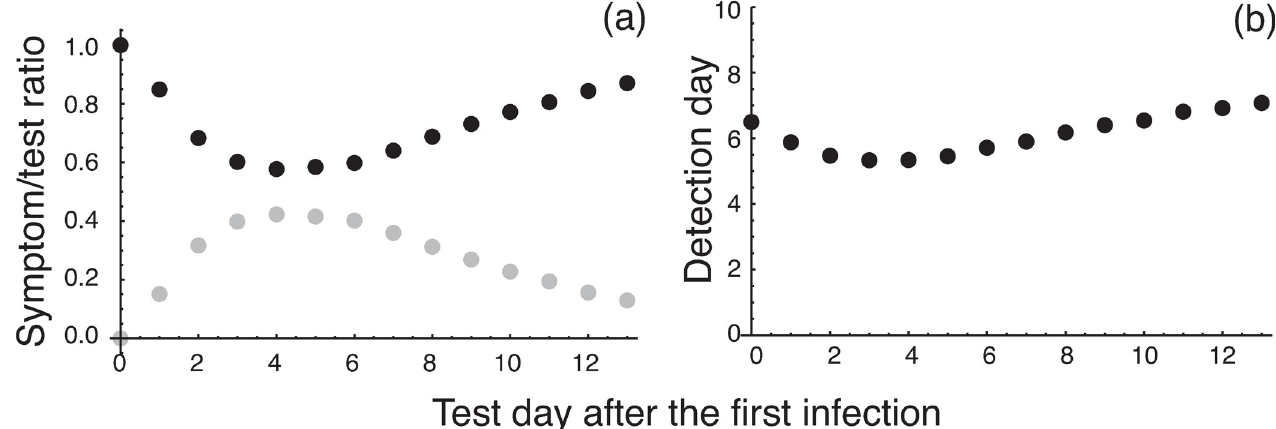
Fig 2. Detection rate of infected individuals (a) and waiting time for infection detection (b). (a) The ratio of infected individuals detected by checking for symptoms (black dots) with respect to those detected by routine PCR testing (gray dots). (b) The average waiting time until detection of infected individuals after the first infection occurred in the group. The overall average is 6.1 days. This implies that the first infected individual in the group occurs about 6 days (on average) before subsequently infected individuals are found.